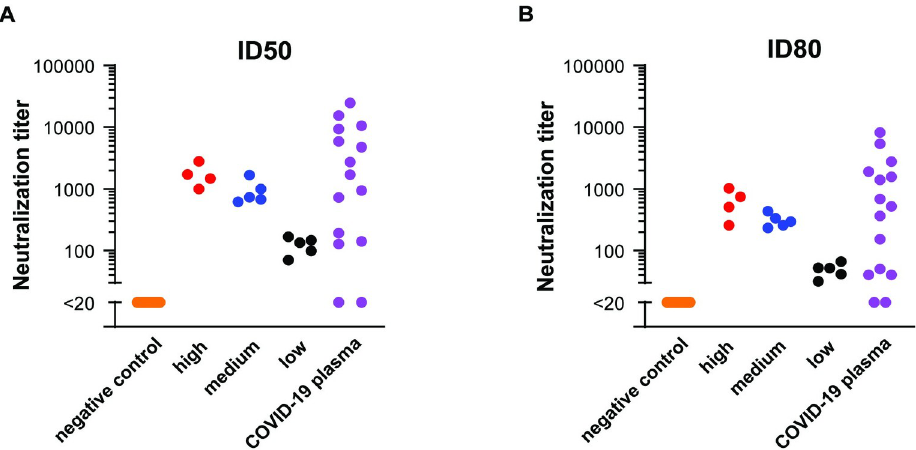
Fig 6. Neutralization titers of serum panels. ID 50 (A) and ID 80 (B) titers. ID 50 = inhibitory dilution leading to 50% neutralization compared to control. ID 80 = inhibitory dilution leading to 80% neutralization compared to control. X- axes indicate sample type. Y axes indicate pseudovirus neutralization titers. Each dot represents an independent sample.